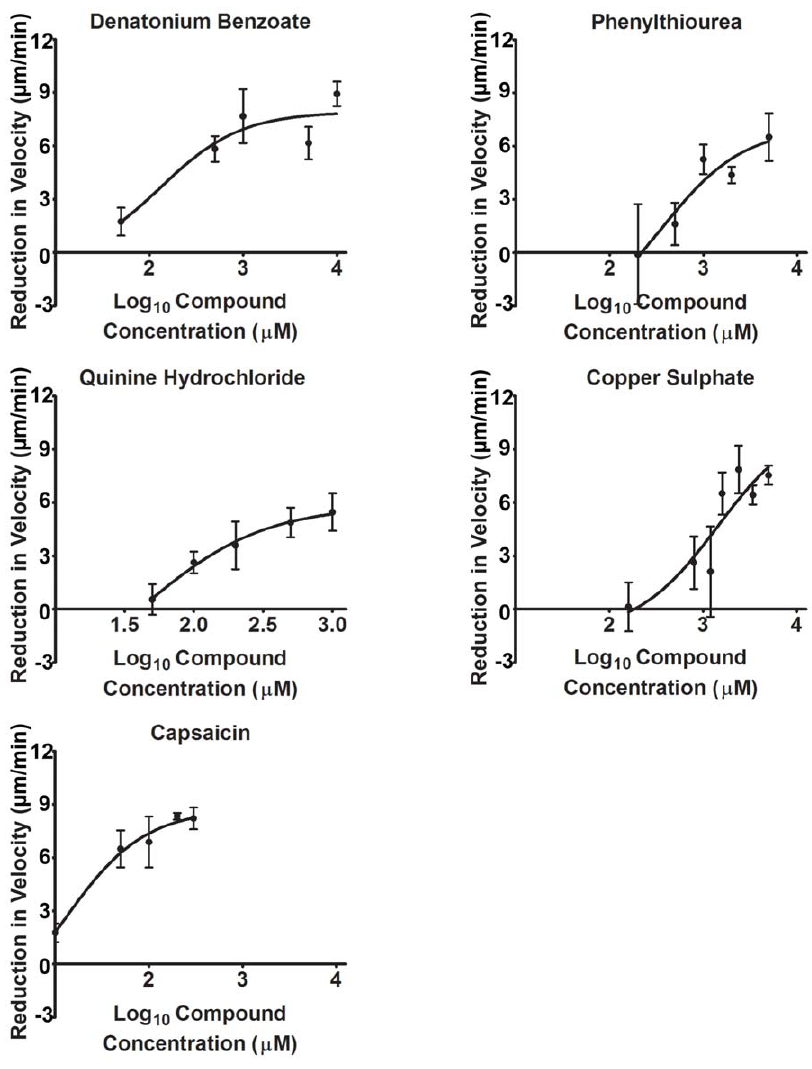
Figure 6. Concentration-dependent reduction of cell velocity for emetic and taste aversive compounds. Reduction in cell velocity compared to untreated cells was plotted against log 10 concentrations, where compound concentration was chosen from those showing a non- significant effect on cell behaviour; up to a maximum of a 200-fold increase from this value. All data is presented as a mean 6 S.E.M of triplicate experiments, comparing mean cell velocity during the first 5 min and final 5 min with increasing